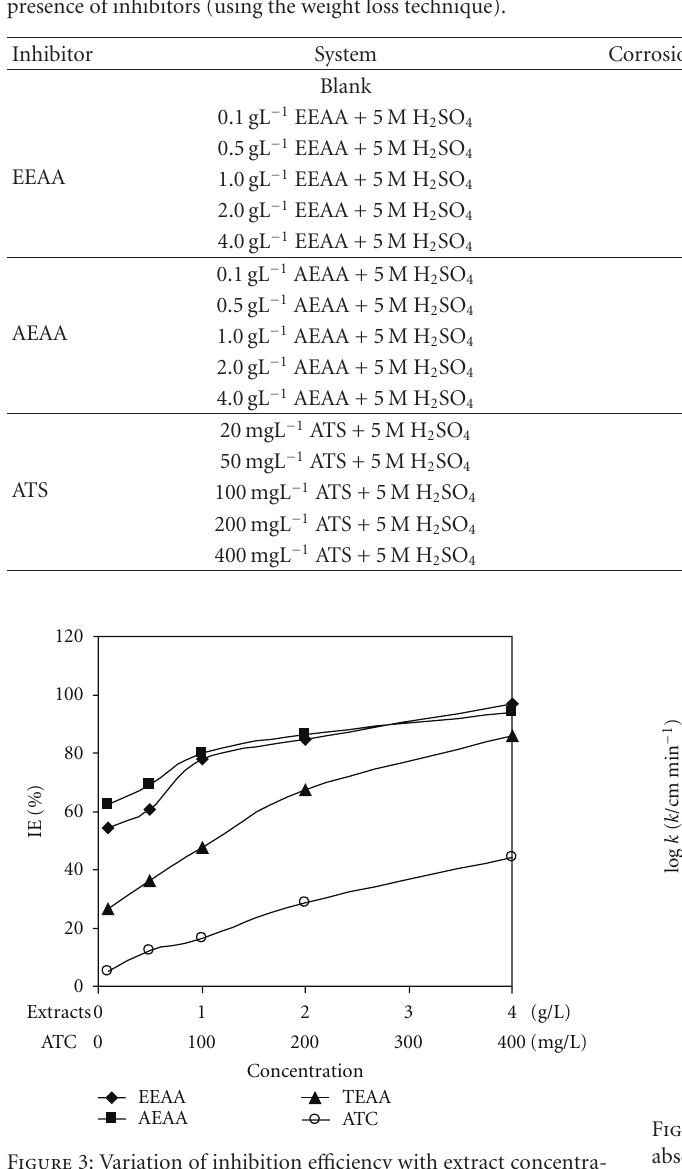
Figure 3: Variation of inhibition e ffi ciency with extract concentra- tion for mild steel in 5 M H 2 SO 4 containing the inhibitors at 30 ◦ C.